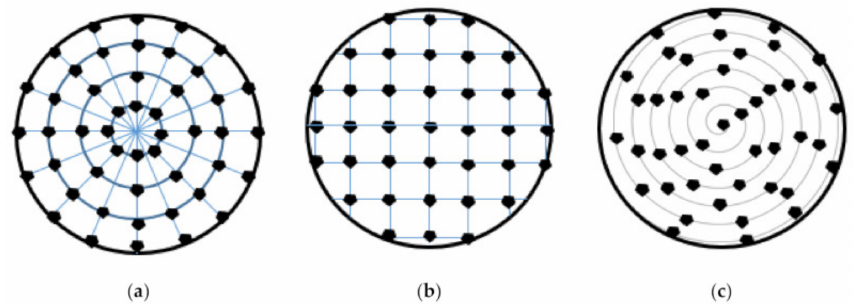
Figure 8. Schematics of circular ( a ), rectangular ( b ) and spiral ( c ) patterns of abrasive grain arrange- ment in an X-Y plane of grinding wheels [212]. Creative Commons (CC BY)